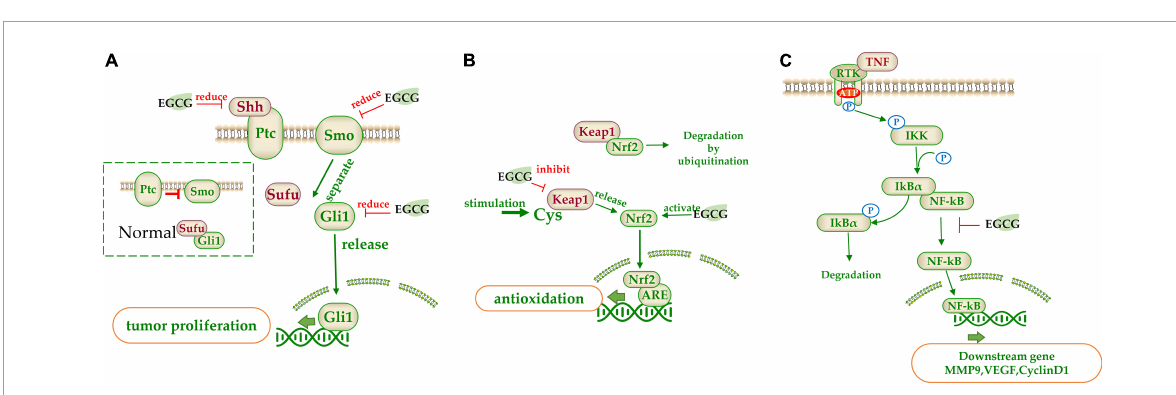
FIGURE5 The target of catechins in the signaling pathway. (A) Sonic hedgehog (SHH) pathway signal pathway; (B) Nrf2 signal pathway; (C) NF- κ B signal pathway. The green arrow represents the signal transmission, red arrow represents